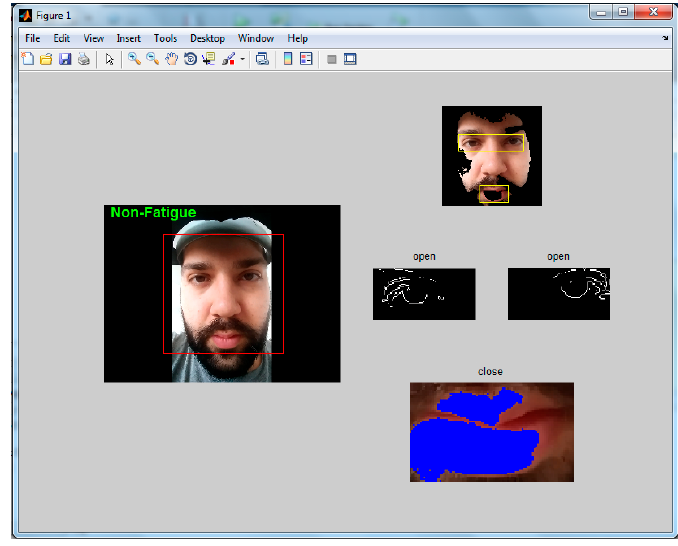
Figure 12. Improvement in face parts detection using the new positioning technique for the camera.